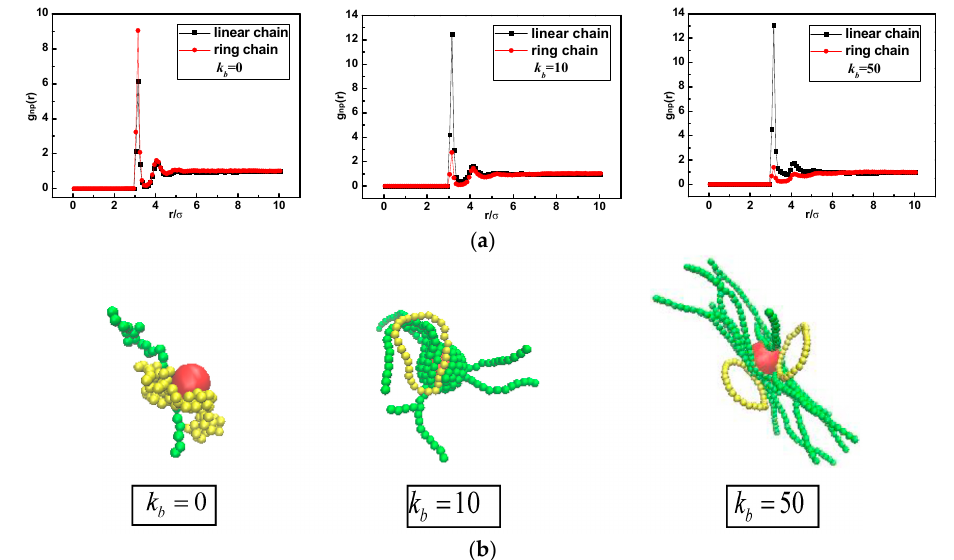
r ; ( b ) snapshots of the conformations of Figure 5. ( a ) Polymer-NP pair distribution function g ( ) np Figure 5. ( a ) Polymer-NP pair distribution function g np ( r ) ; ( b ) snapshots of the conformations of ε nanocomposites with = 10.0 np . nanocomposites with ε np =